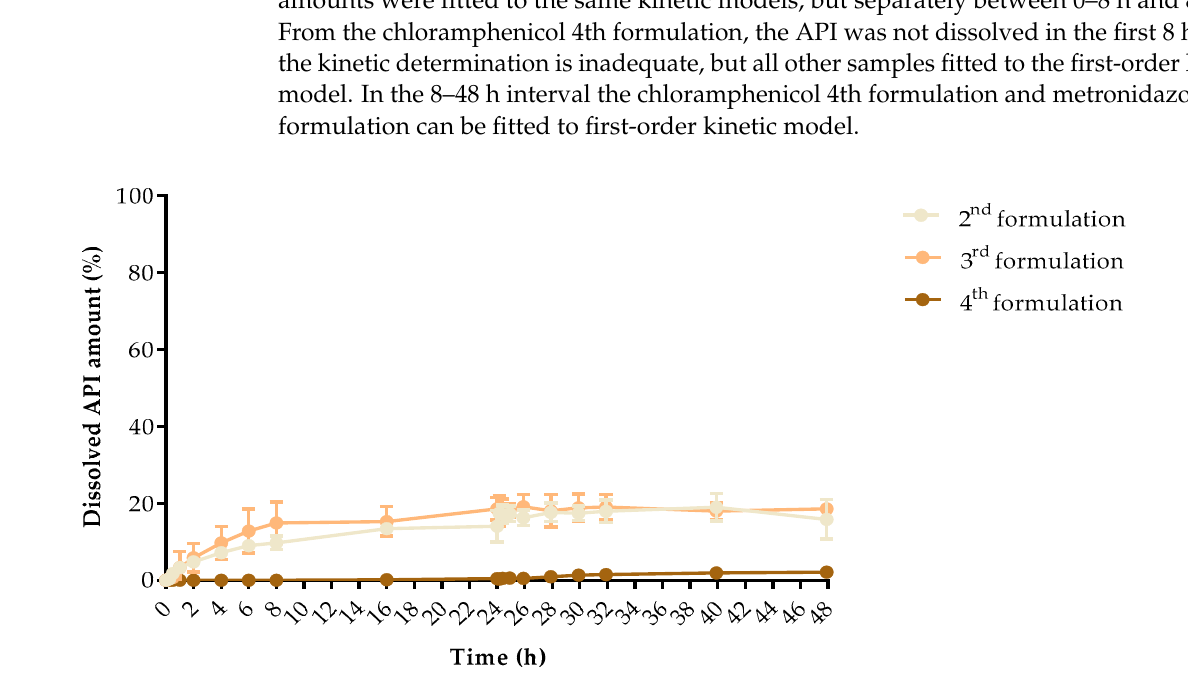
Figure 9. Dissolved API amount (%) versus time (h) for samples jellified with chloramphenicol; mean ± SD, n = 4.